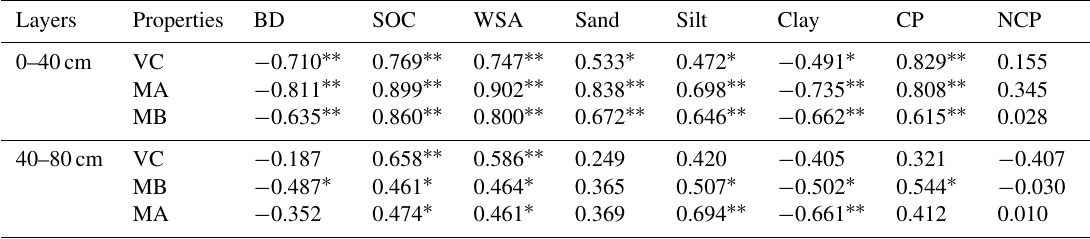
Table 2. Pearson correlation coefficients between vegetation characteristics and soil properties in 0–40 and 40–80cm layers. Layers